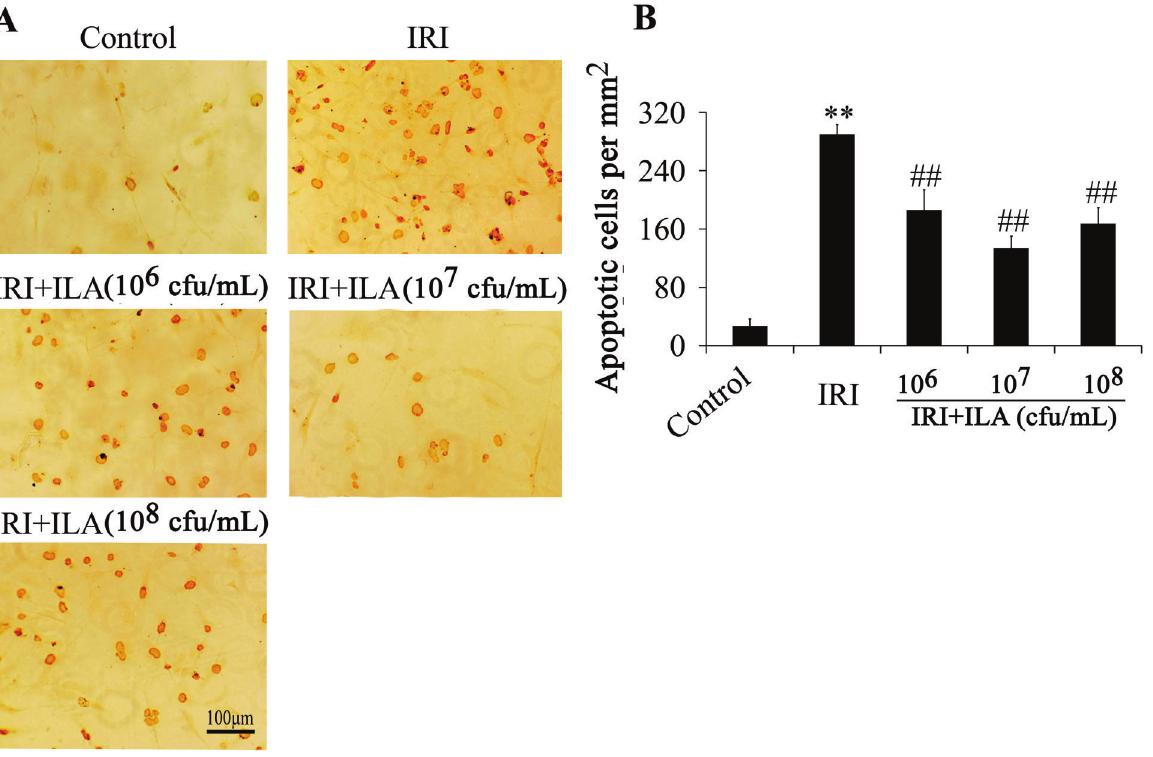
Figure 3. Effect of different concentrations of inactivated lactobacillus (ILA) on ischemia reperfusion injury (IRI) in neural cell apoptosis in frontal cortex was assayed by TUNEL assay ( A ) (n=4). Scale bar: 100 m M. B , Data are reported as means ± SD. **P o 0.01 vs control; ## P o 0.01 vs IRI (ANOVA, followed by Duncan ’ s multiple range